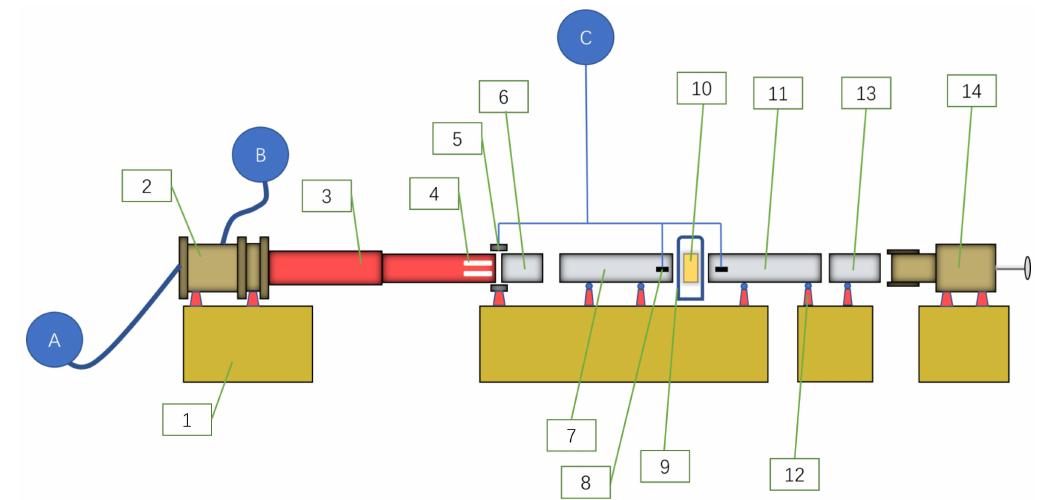
Figure 3. Schematic diagram of each component of SHPB test device.